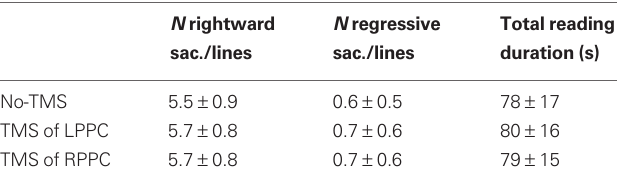
Table 1 | General reading characteristics: number of saccades, number of regressive saccades (within a line of text, saccades of return to the next line excluded) and total reading duration (mean ±